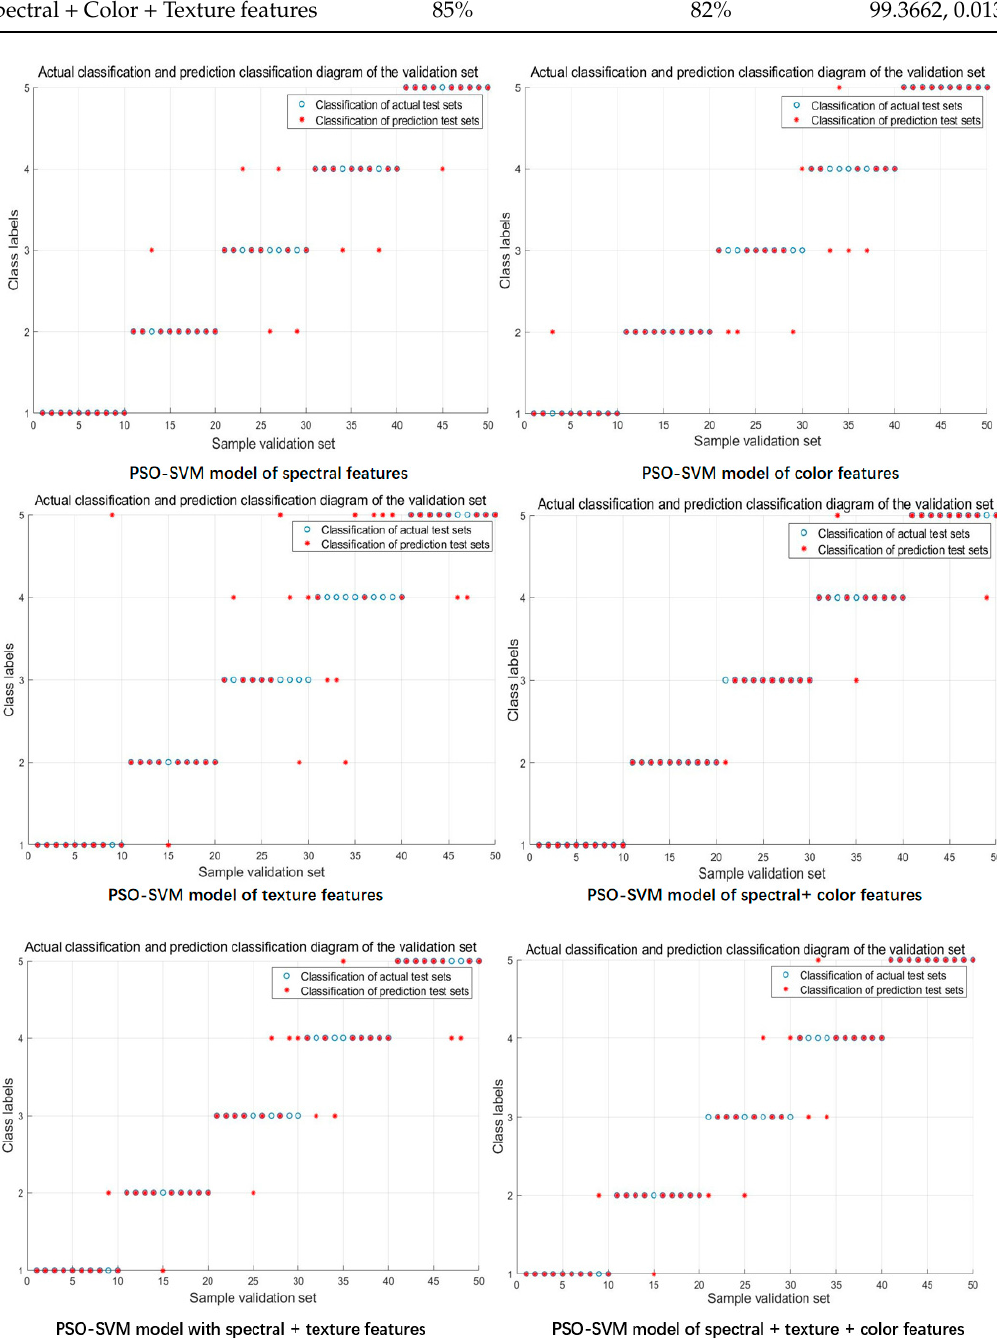
Figure 9. PSO_SVM model prediction results with different feature information.